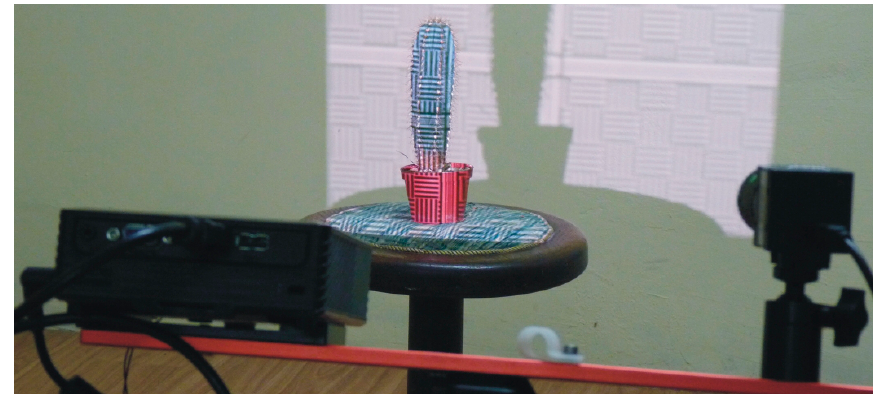
Figure 1. Scanning a succulent plant in the pot with the structured light-based DAVID Laserscanner [17].